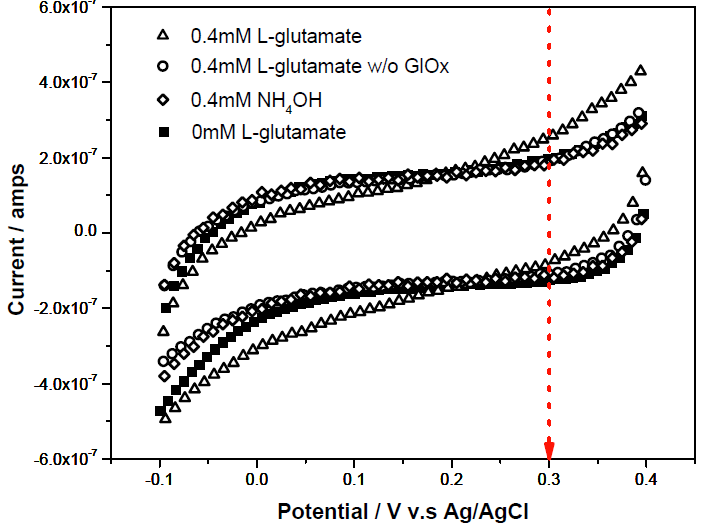
Figure 2. Cyclic voltammograms of background (0 mM L-glutamate) and 0.4 mM NH OH, and 0.4 mM L-glutamate in a basic testing solution in the absence or presence of 4 0.05 U/µL GluOx as testing solution (each measurement repeated 3 times using a fresh sensor).